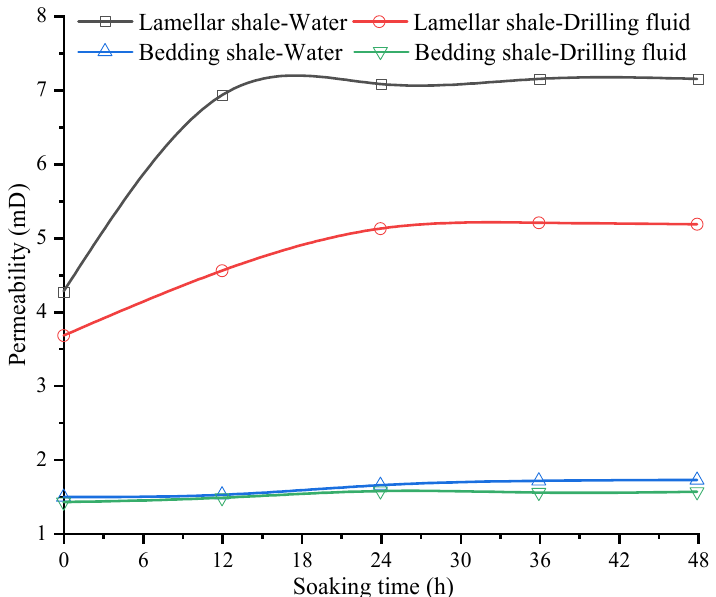
Figure 8. The relationship between permeability and soaking time under 0 ◦ sampling, the lamina density in the lamellar shale sample is